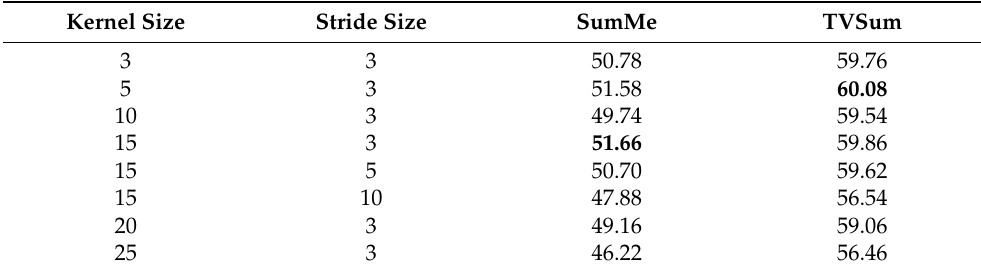
Table 1. Results (F-measure, %) of the comparison among our methods with different kernel and stride